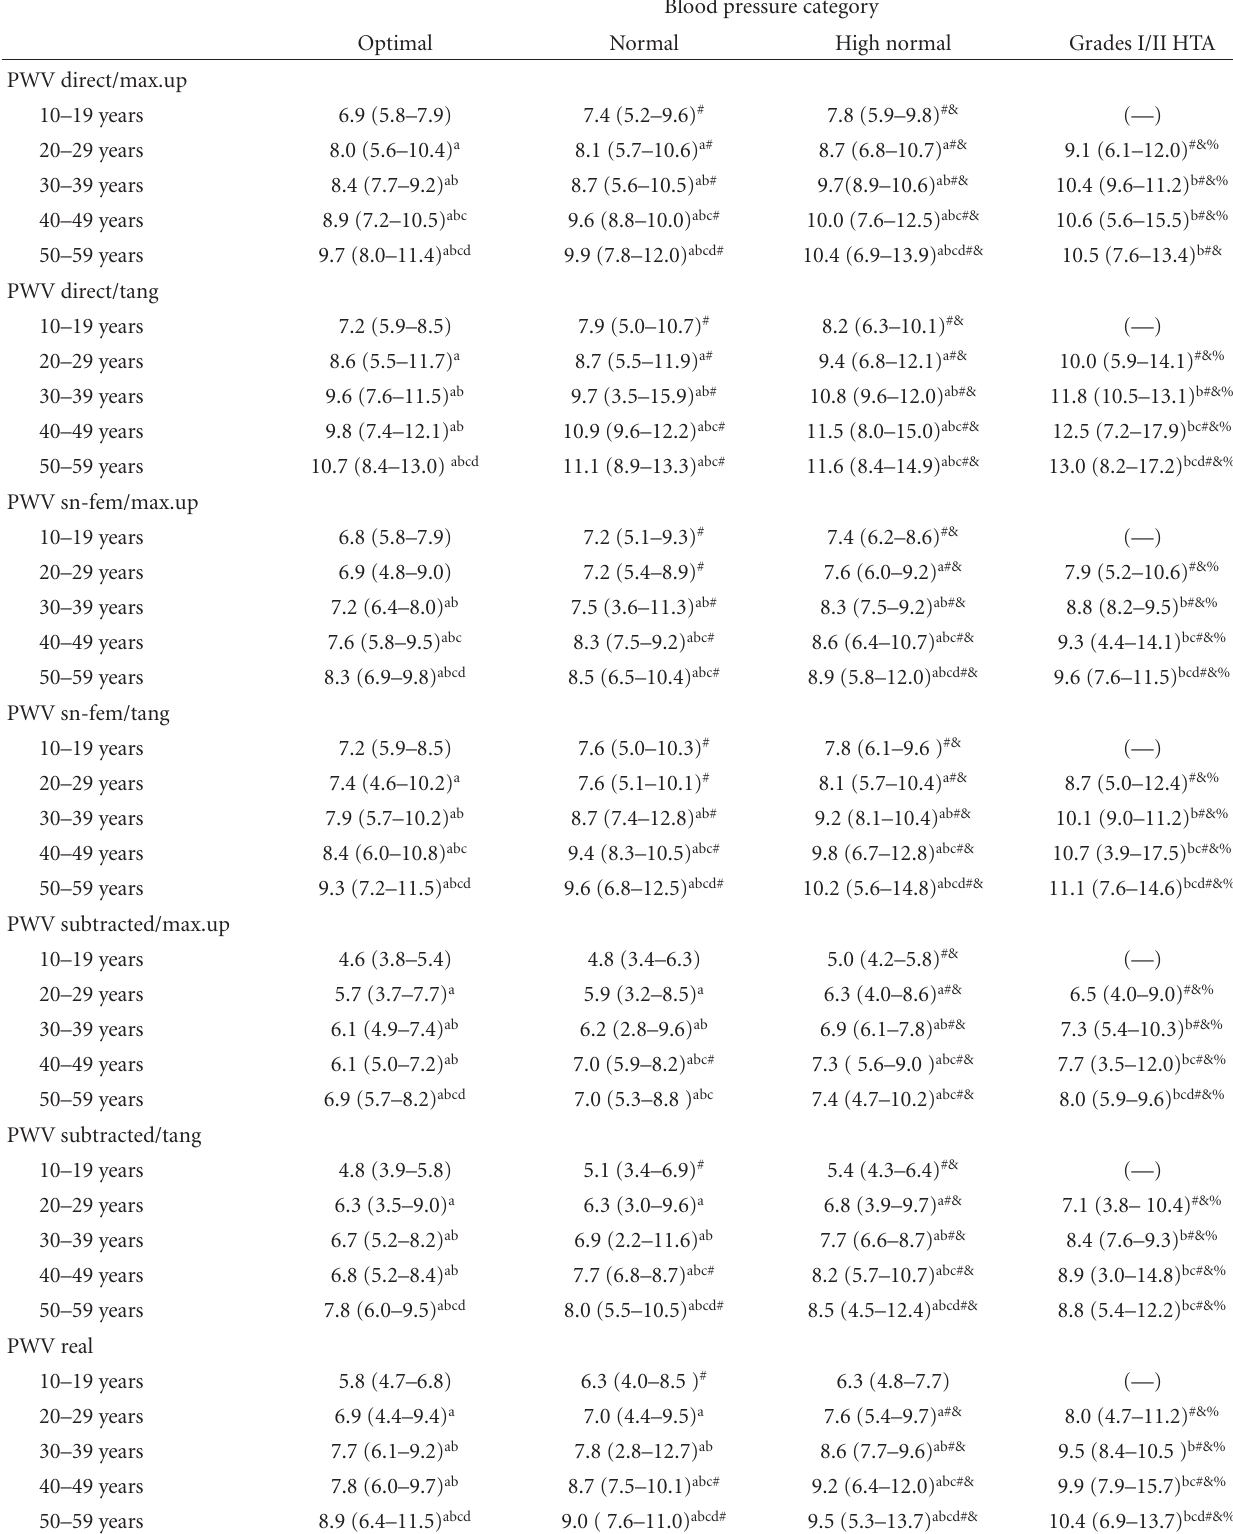
Table 4: PMV levels considering age and blood pressure. Blood pressure category Optimal Normal High normal Grades I/II